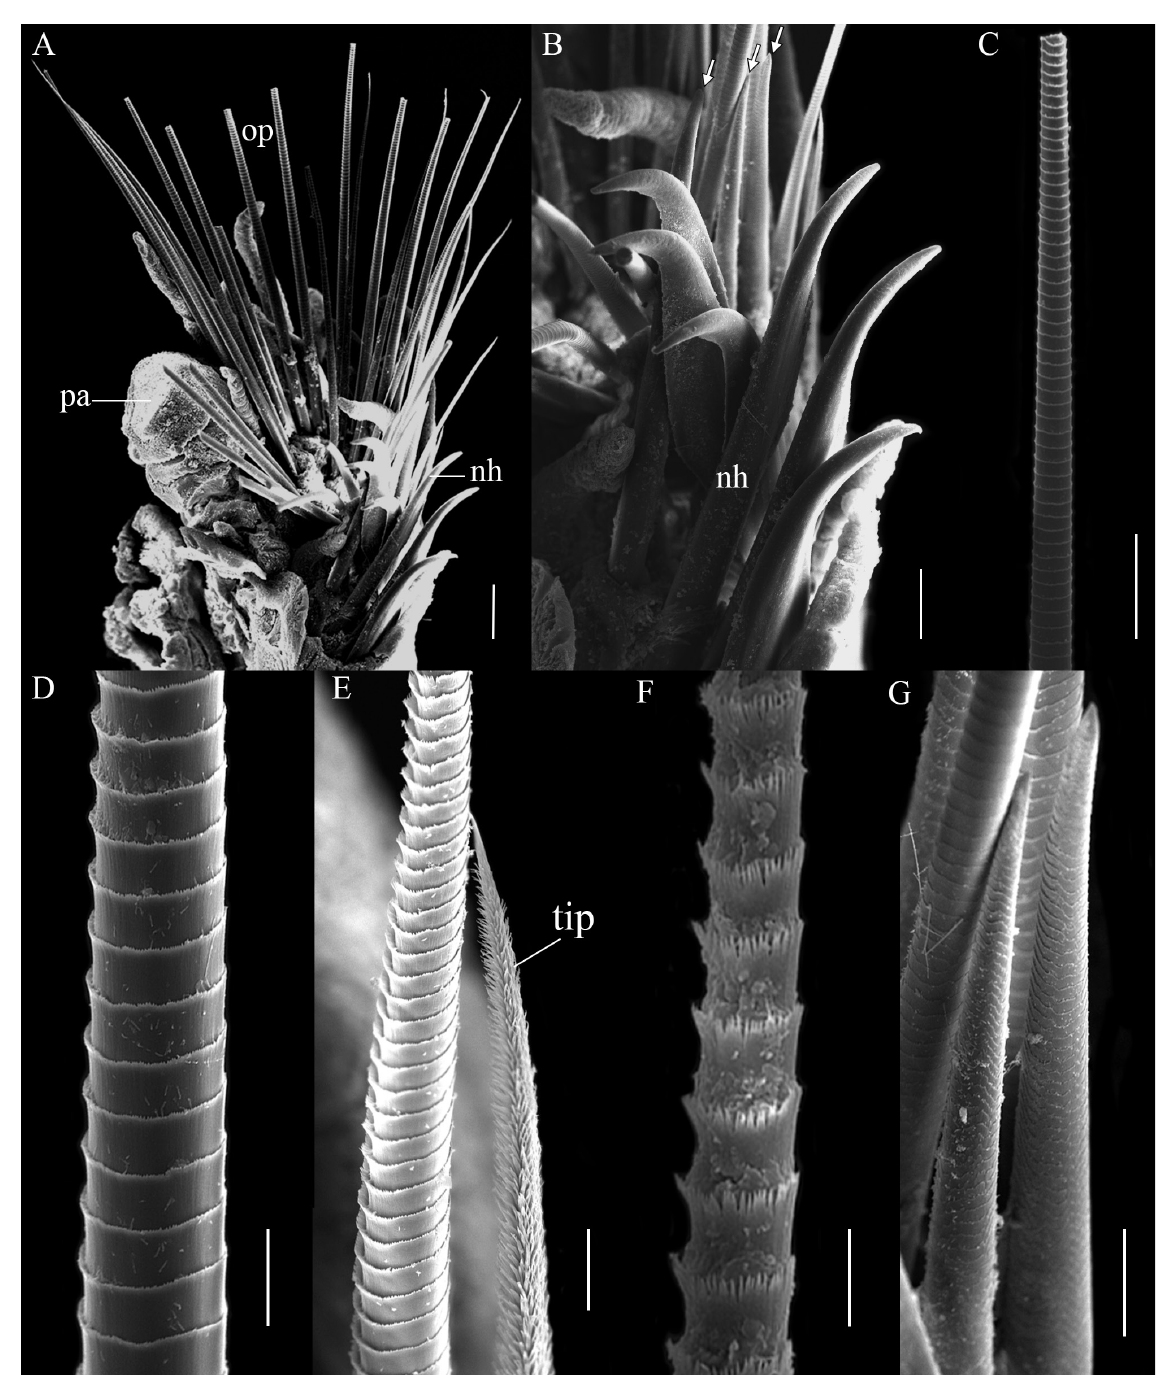
Fig. 7. Phalacrostemma danieli sp. nov., paratype (UMML-22.1181). A . Right opercular lobe. B . Nuchal hooks. C–D . Basal region of outer palea. E . Middle region and tip of outer paleae. F . Middle-distal region of outer palea. G . Inner paleae. Abbreviations: nh = nuchal hooks; op = outer paleae; pa = palps; tip = outer palea tip. Arrows indicate inner paleae. Scale bars: A = 200 µm; B–C = 100 µm; D = 20 µm; E, G = 50 µm; F = 10